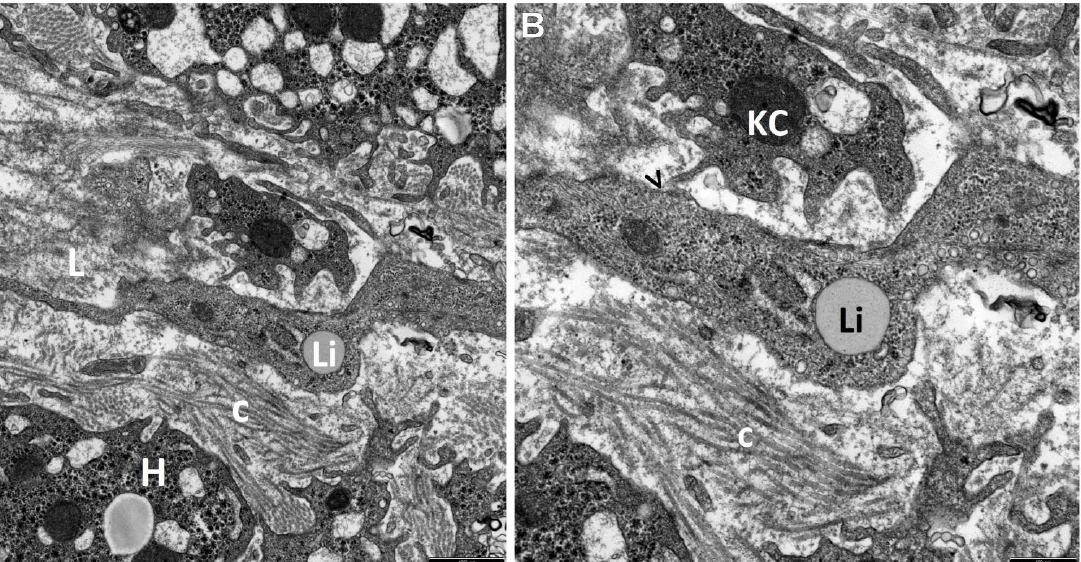
Figure 3. ( A , B ) An electronogram demonstrating a fragment of an elongated perisinusoidal stellate pHSC containing a single lipid droplet (Li), weakly dilated ger channels, and a relatively well-pre- served mitochondrion. A fine cytoplasmic process (>) of a Kupffer cell (KC) adheres directly to the upper pole of the pHSC; the lower pole is enclosed by a bundle of mature collagen fibers — c (visible is longitudinal section through these fibers). The vacular pole of the hepatocyte (H) is smoothed in places; L—sinusoidal vascular lumen. Scale bar 1 µ m, original magnification × 7000 ( A ); scale bar 0.5 µ m, original magnification × 12,000 ( B